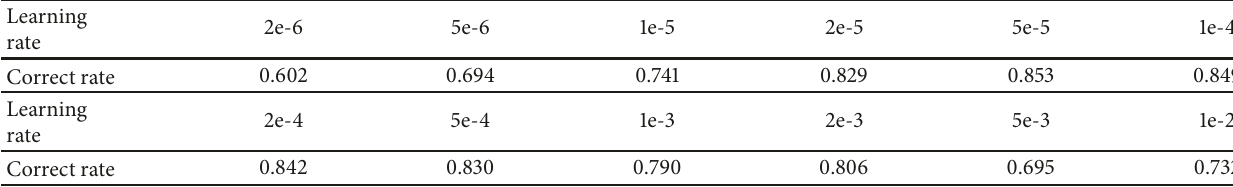
Table 1: Correct rates of test set under different learning